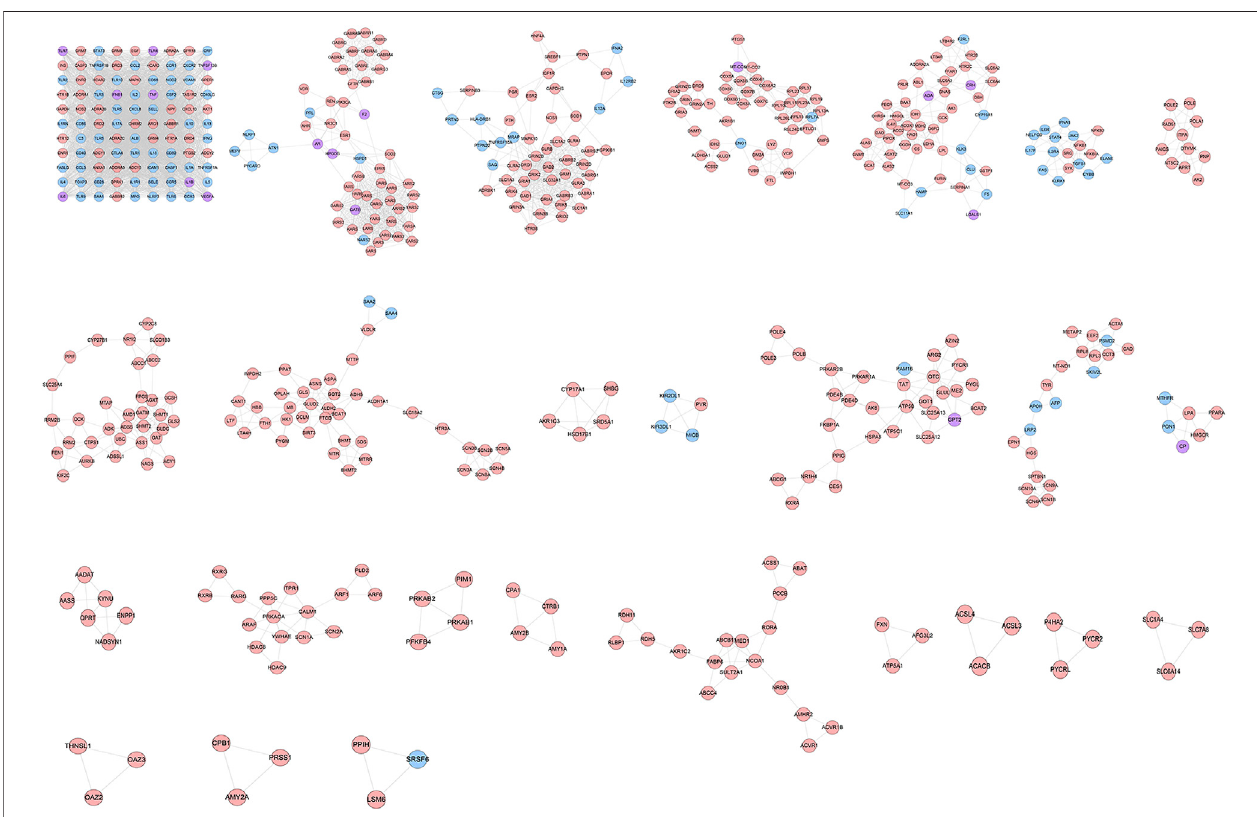
FIGURE 4 | Clusters of ZBDHD-orchitis PPI Network (Pink circles stand for ZBDHD target, Blue circles stand for orchitis targets, purple circles stand for ZBDHD- orchitis